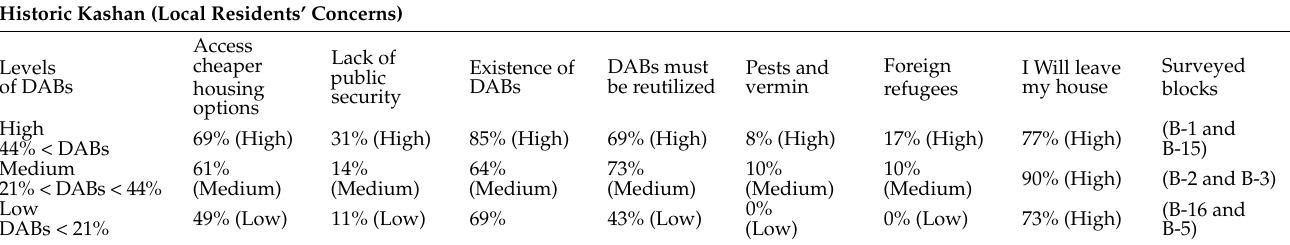
Table 3. Analysing aspects of spatial liminality in 12 urban blocks.